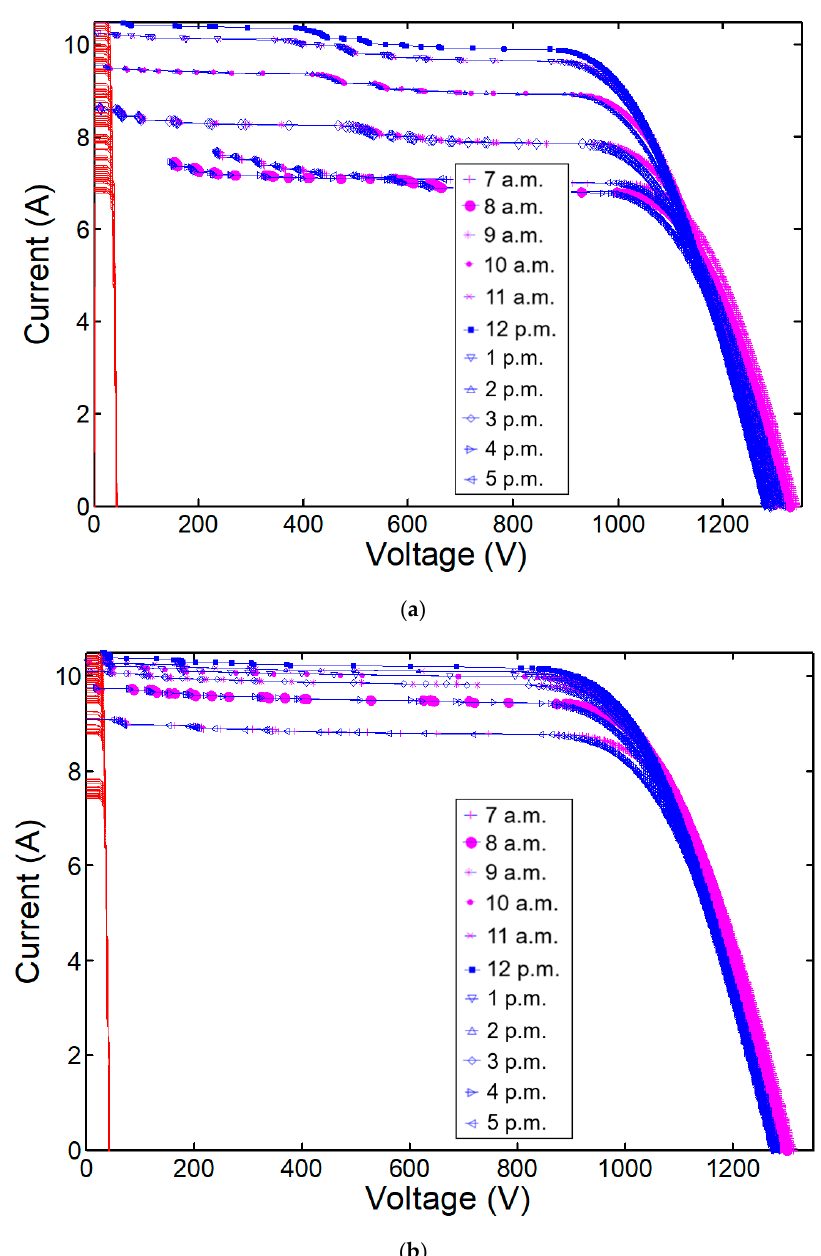
Figure 4. Module I–V characteristics (red continuous curves) and corresponding electrical characteristics of 30-module PV string (blue curves with markers), as calculated by the model proposed, at time intervals of 1 h, between 7 a.m. and 5 p.m. of day n. 180 at the latitude of Catania, Italy, for both the cases of: ( a ) fixed string and ( b ) string with uniaxial horizontal solar tracker.